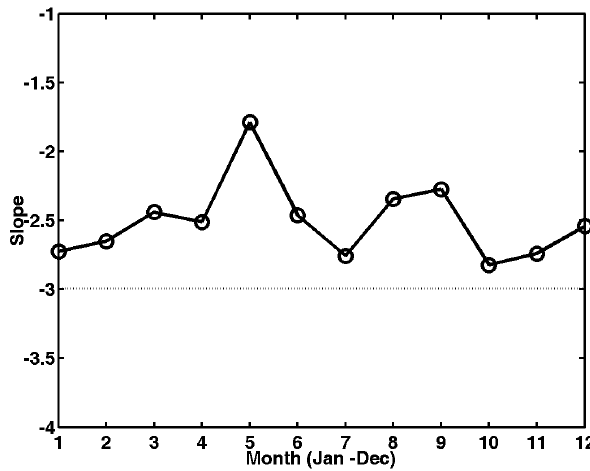
Fig. 7. Monthly variation of logarithmic spectral slopes. The dotted line shows the theoretical